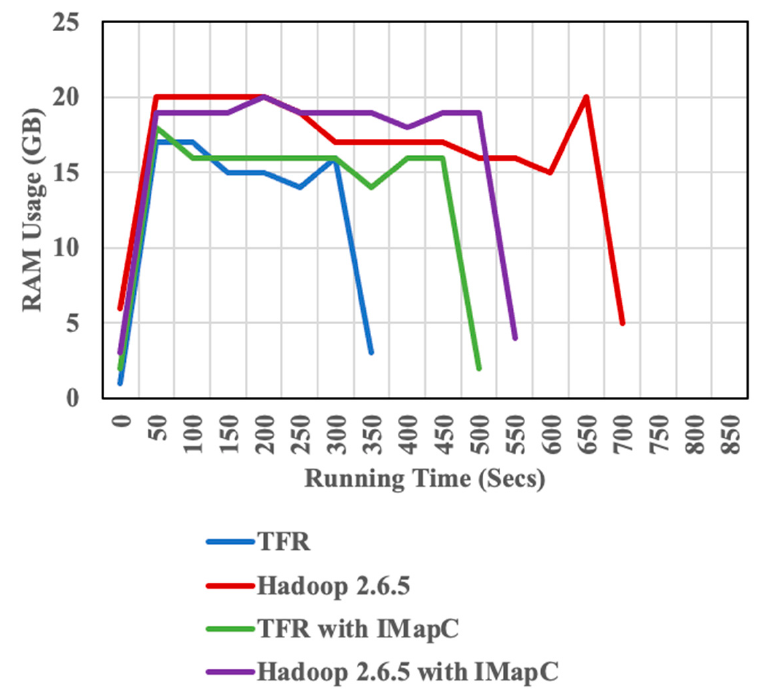
Figure 13. Memory usage on running Sort job.